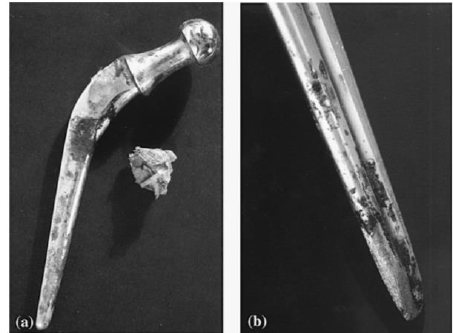
Figure 4: a) Corrosion scale on a Charnley stainless steel stem, and (b) pitting and corrosion of a Muller stainless steel stem after implant removal [40].